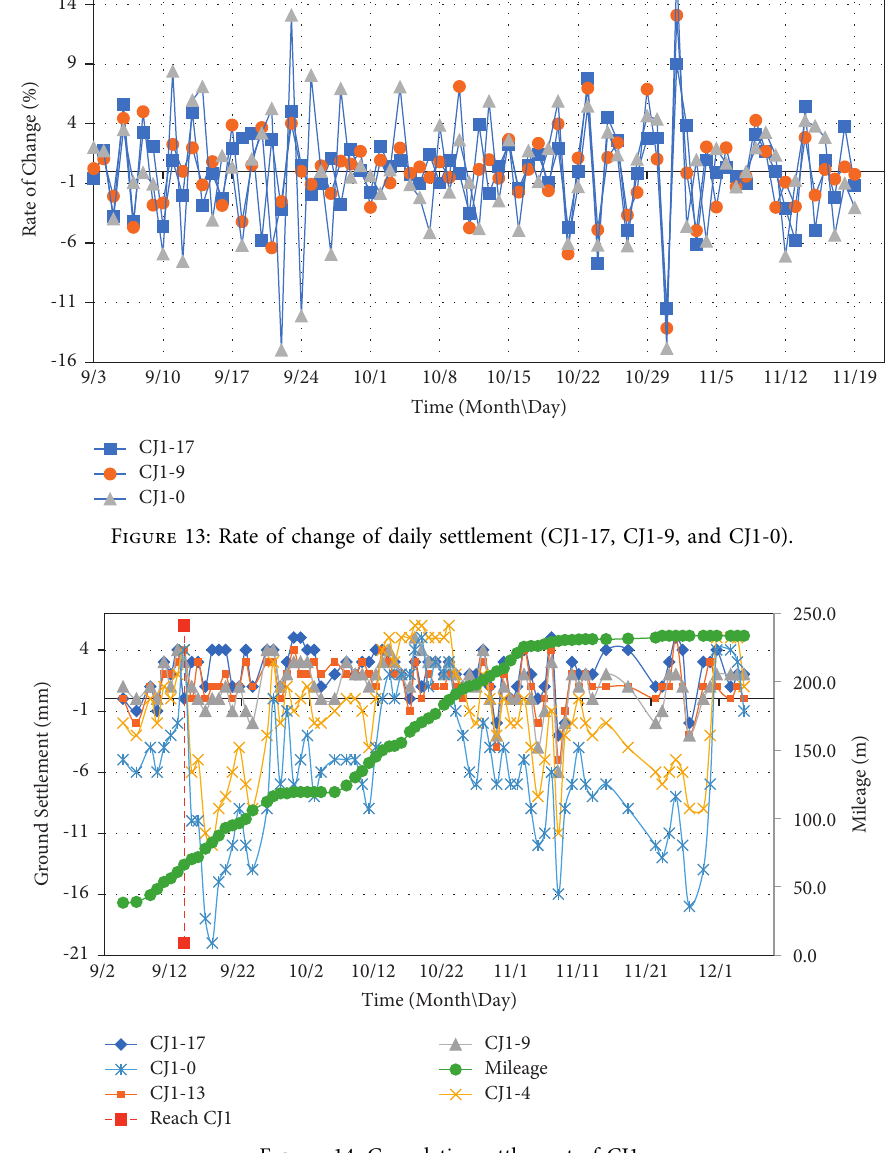
Figure 14: Cumulative settlement of CJ1.